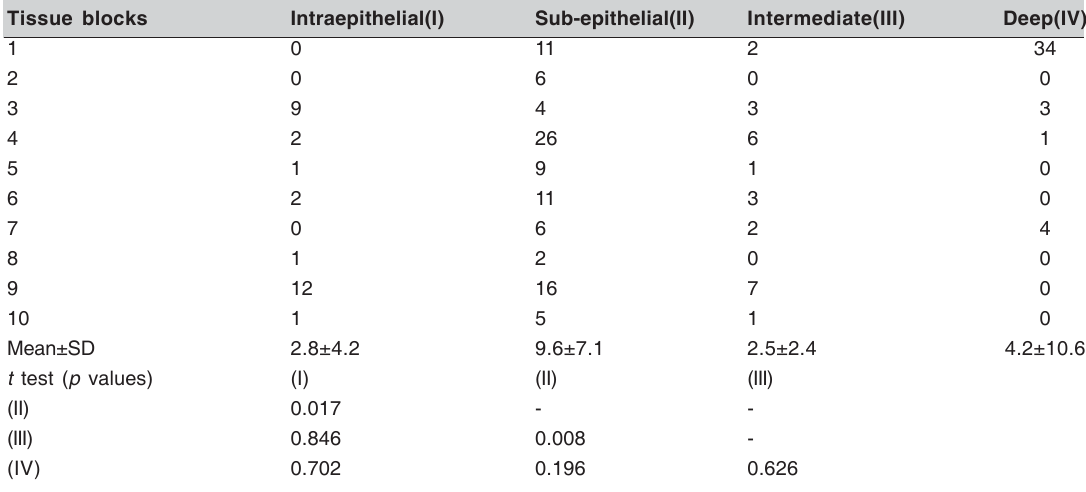
Table 3 - Mast cell distribution in radicular cysts (Mean ± standard deviation and p values of t test between